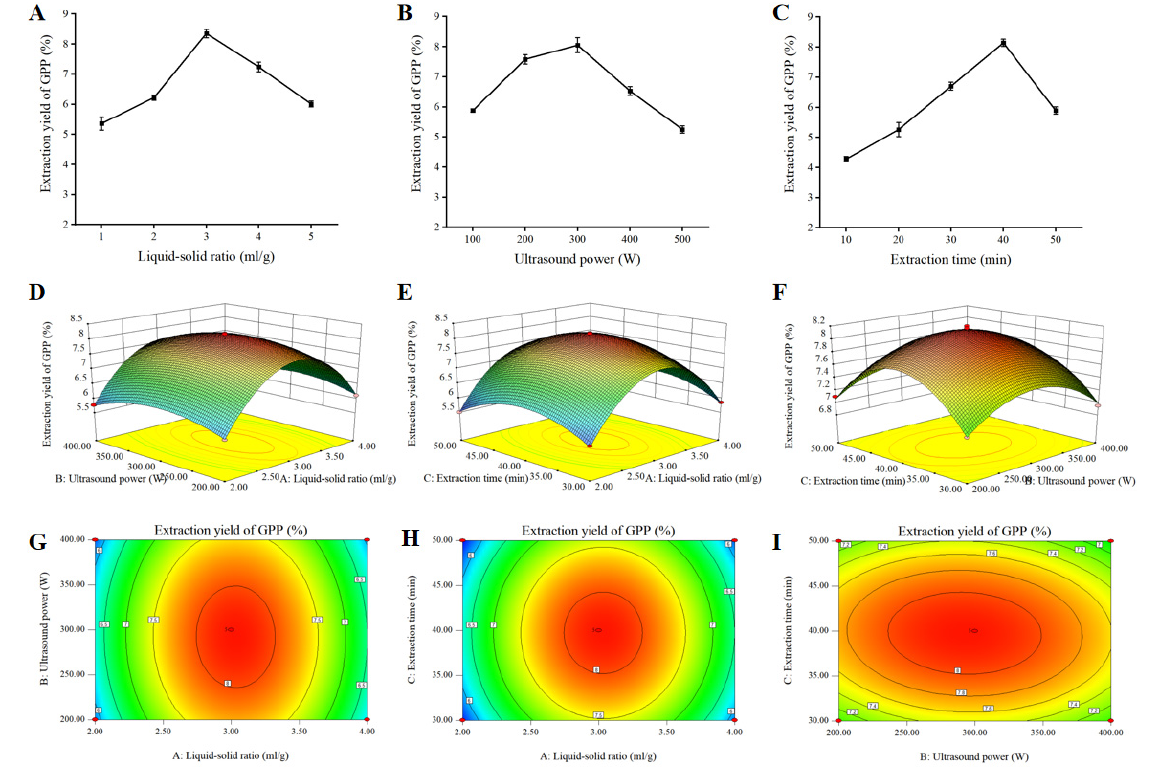
Figure 1. Single-factor experiment results and response surface plots showing the effects of interactions among different selected factors on the extraction yield of grape pomace polysaccharides (GPPs). ( A – C ) Effects of different liquid–solid ratio ( A ), ultrasound power ( B ) and extraction time ( C ) on the yield of GPPs in single-factor experiments. ( D – I ) Three- and two-dimensional plots showing the effects of liquid–solid ratio ( D , G ), ultrasound power ( E , H ) and extraction time ( F , I ) on extraction yield of GPPs, respectively. Table 2. Box–Behnken design (BBD) matrix of the three variables in coded units and response values Table 1. Factors and level values of Box–Behnken. for the extraction rate of